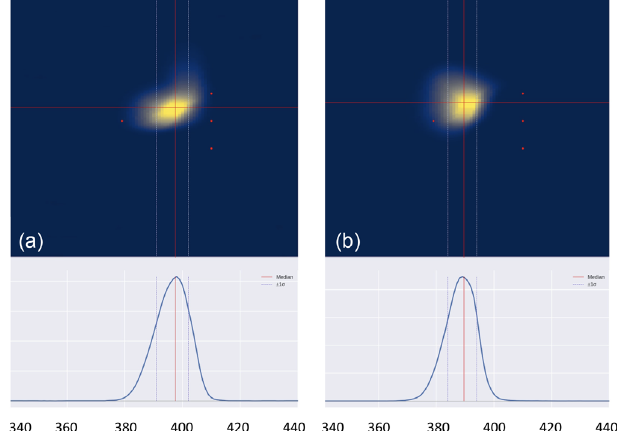
recoilFIG. 6. (a) Nominal and (b) after the GP optimization of the width at FP2 for the 133 Cs commissioning run (see Table II). Red dots indicate 5 mm. X-axis scale is in pixels, where 31 pixels is 5 Fig. 6. The total shift in x-position between the two images is about 1.3 mm and no significant change in the length in the y-direction is seen.